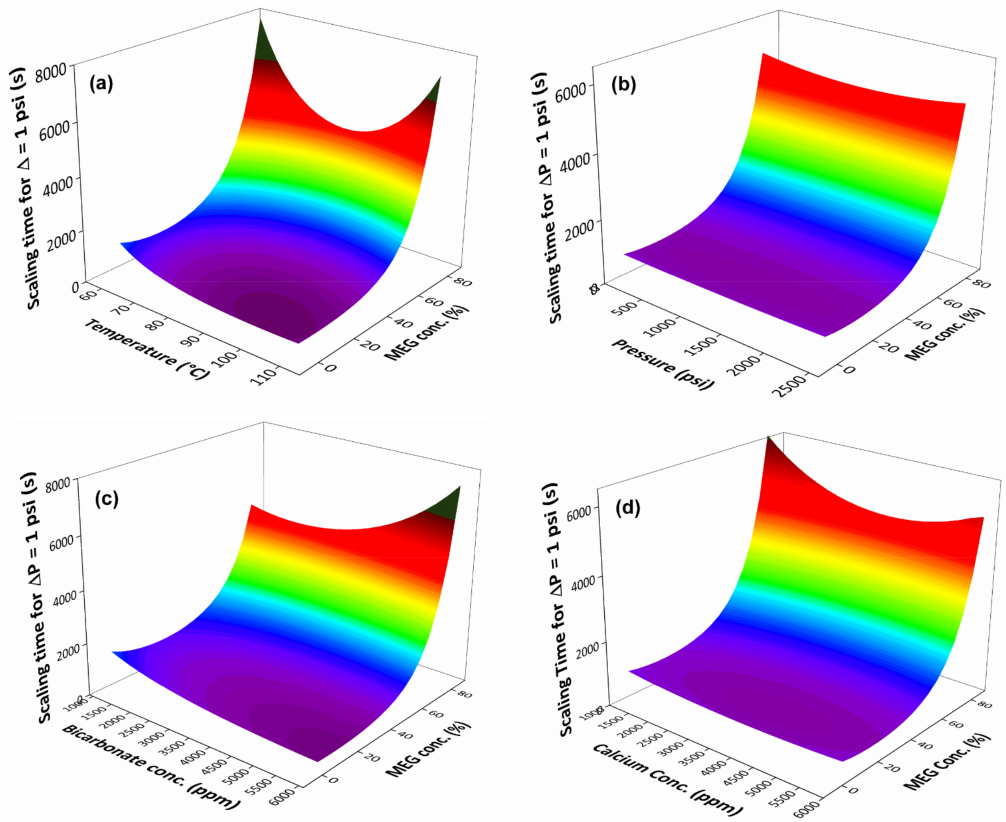
Figure 6. Modelled response surface of the initial scaling time for varying MEG concentration and: ( a ) temperature, ( b ) pressure, ( c ) bicarbonate concentration, and ( d ) calcium